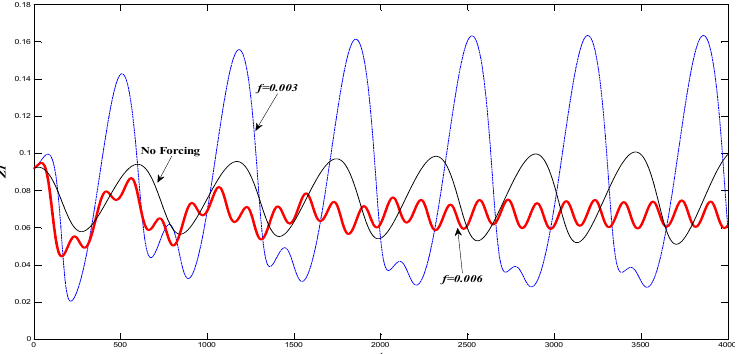
Figure 7. Oscillatory behavior for di ff erent forcing frequencies, where forcing amplitude is constant, A = 0.006 m 3 /